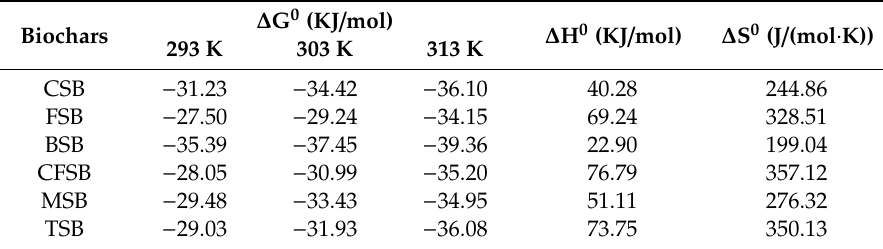
Table 4. Endothermic thermodynamic parameters of Cr(VI) by biochar